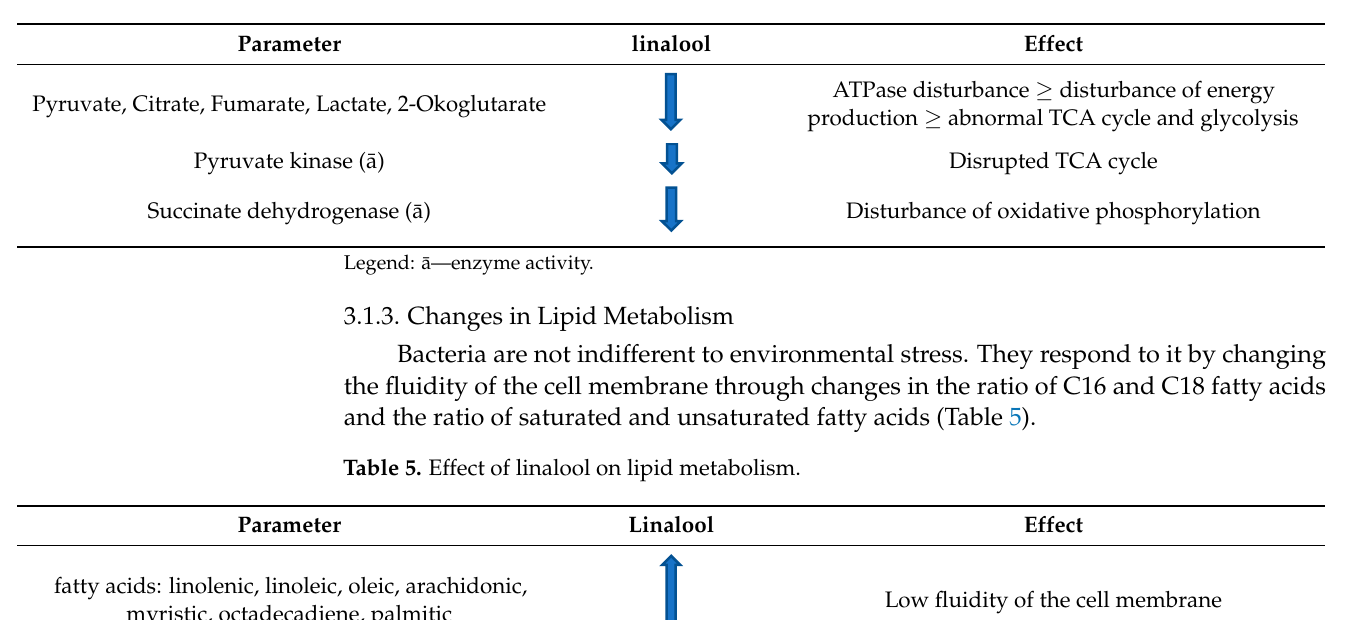
Table 4. Effect of linalool on carbohydrate metabolism.